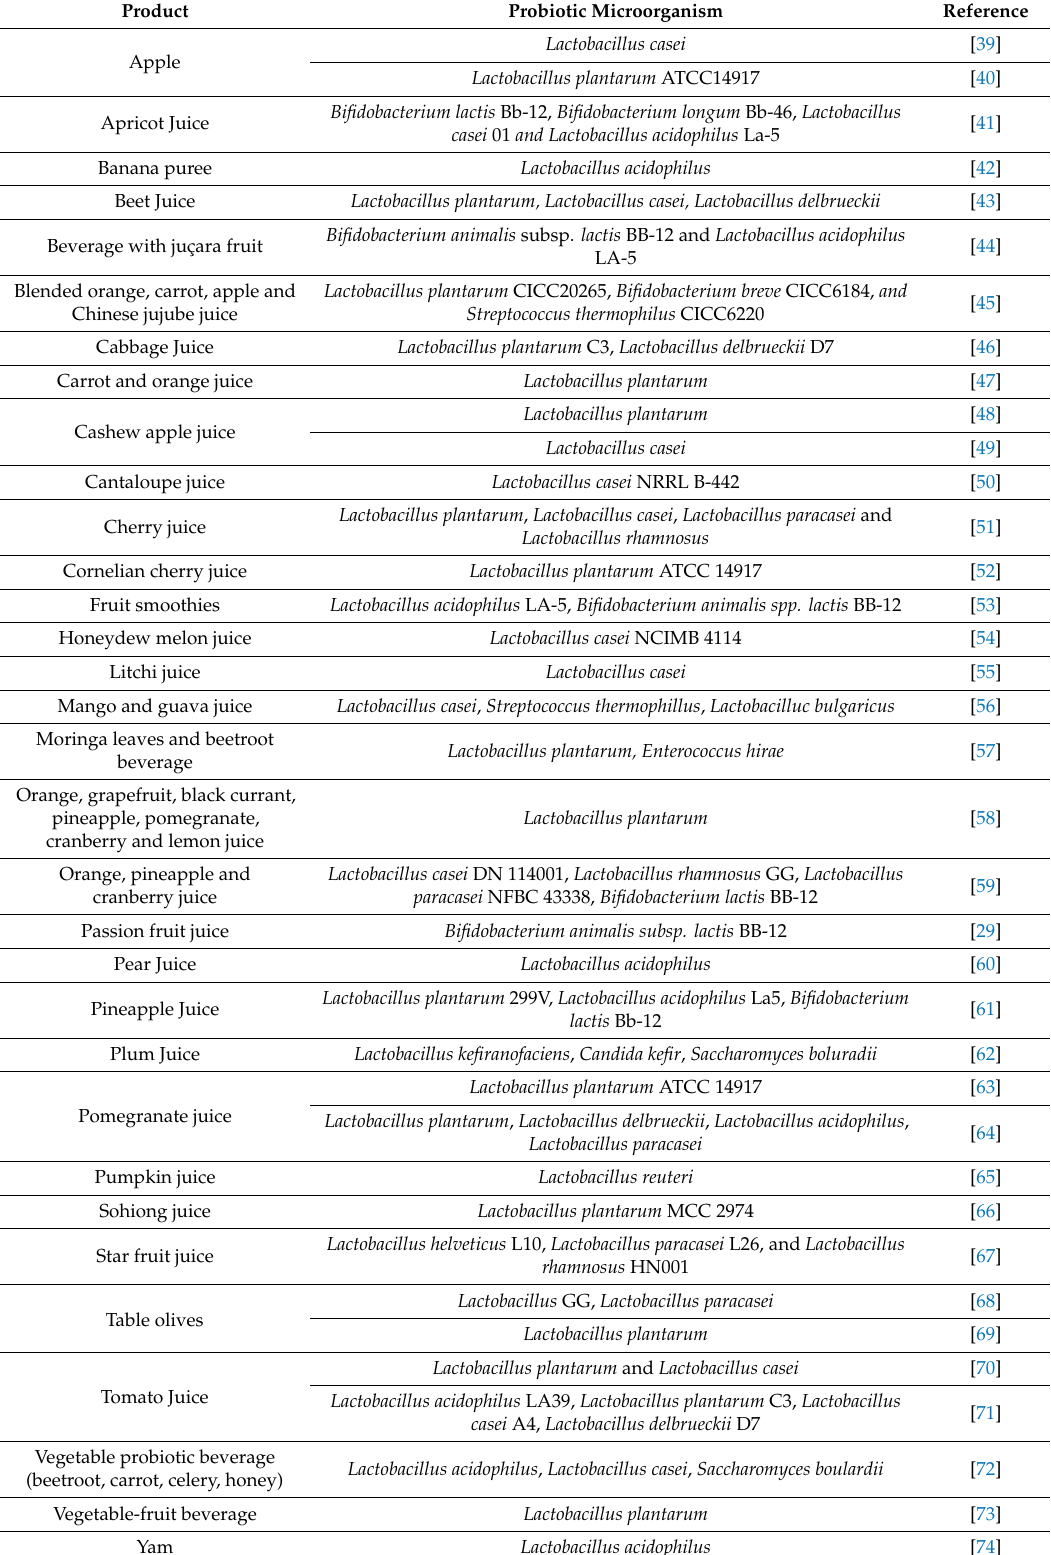
Table 3. Examples of fruit and vegetables probiotic